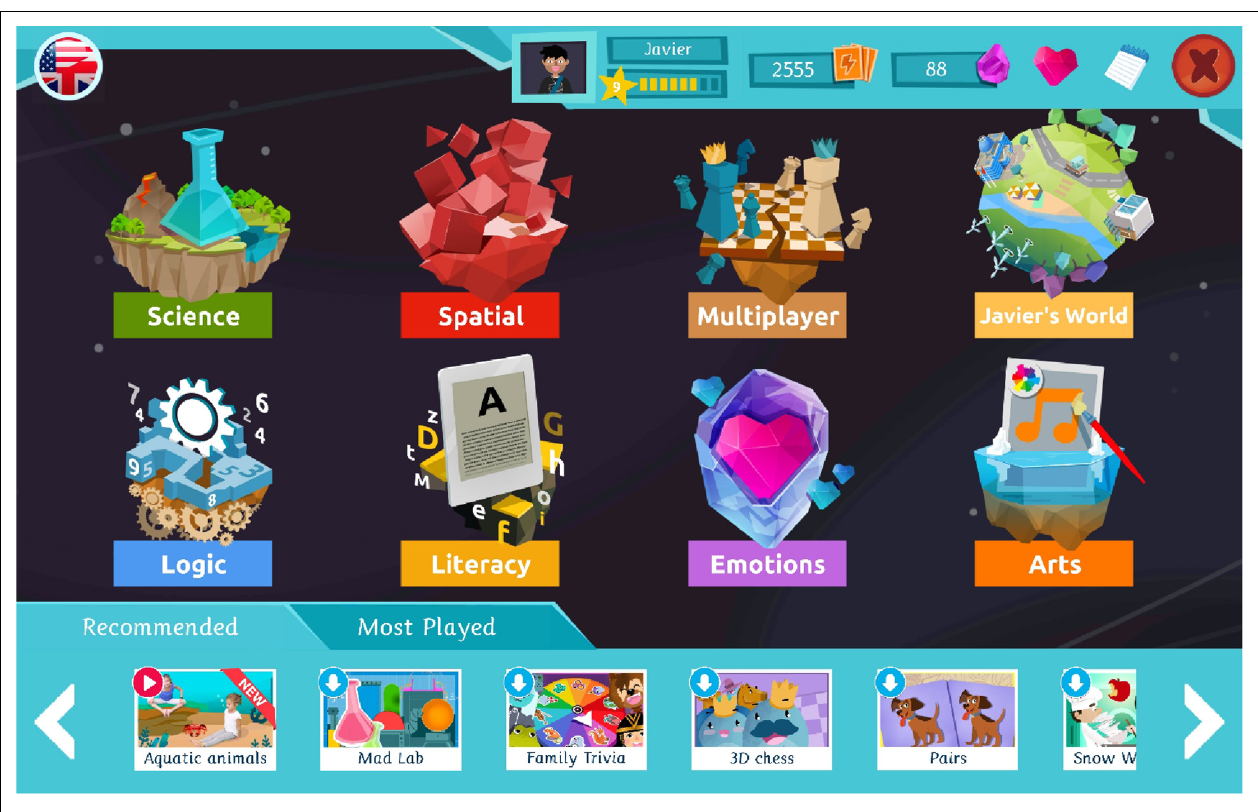
FIGURE 1 | Screenshot of Smile and Learn’s main